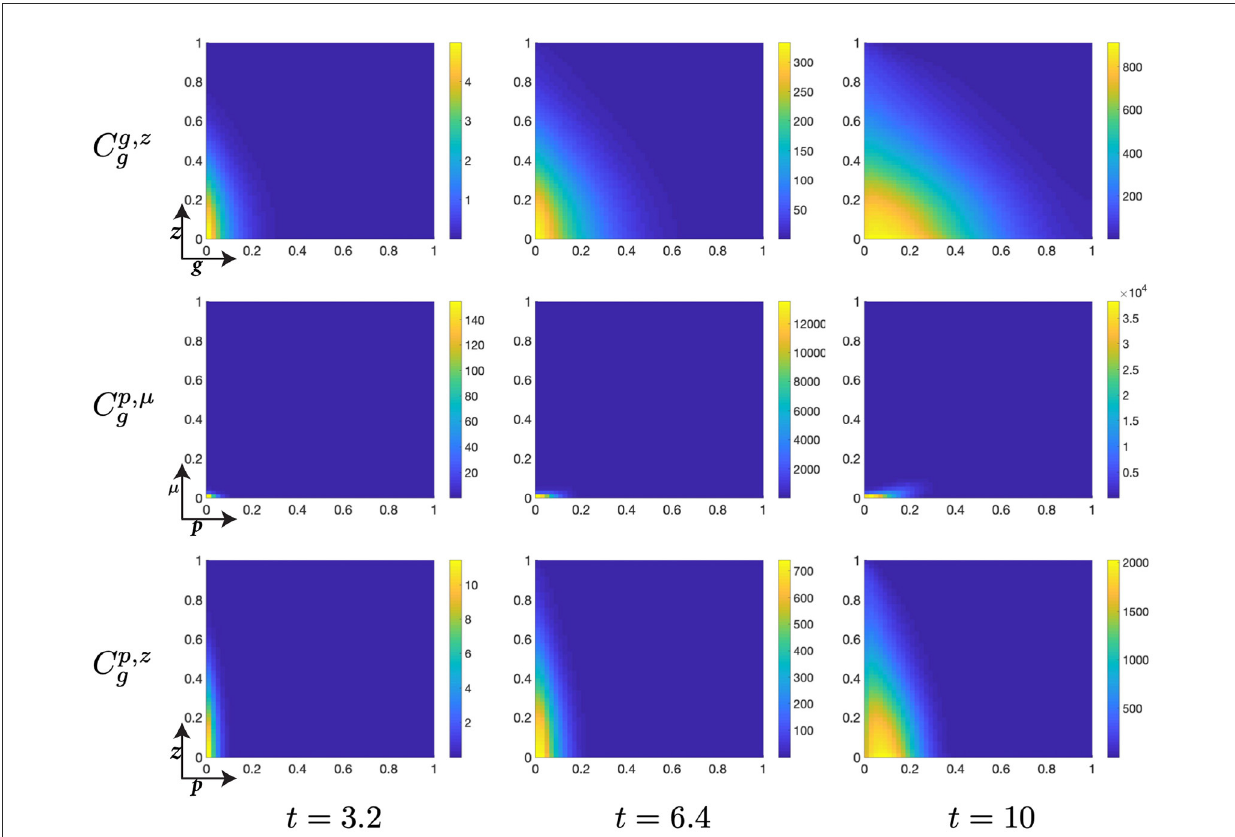
FIGURE9 Structured G-phase cell population given in: the G-cyclin-DNA-damage plane ( g , z ); the p53-mdm2 plane ( p , µ ); and the p53-DNA-damage plane, solved for t 3.2, 6.4, 10 , ∈ { }